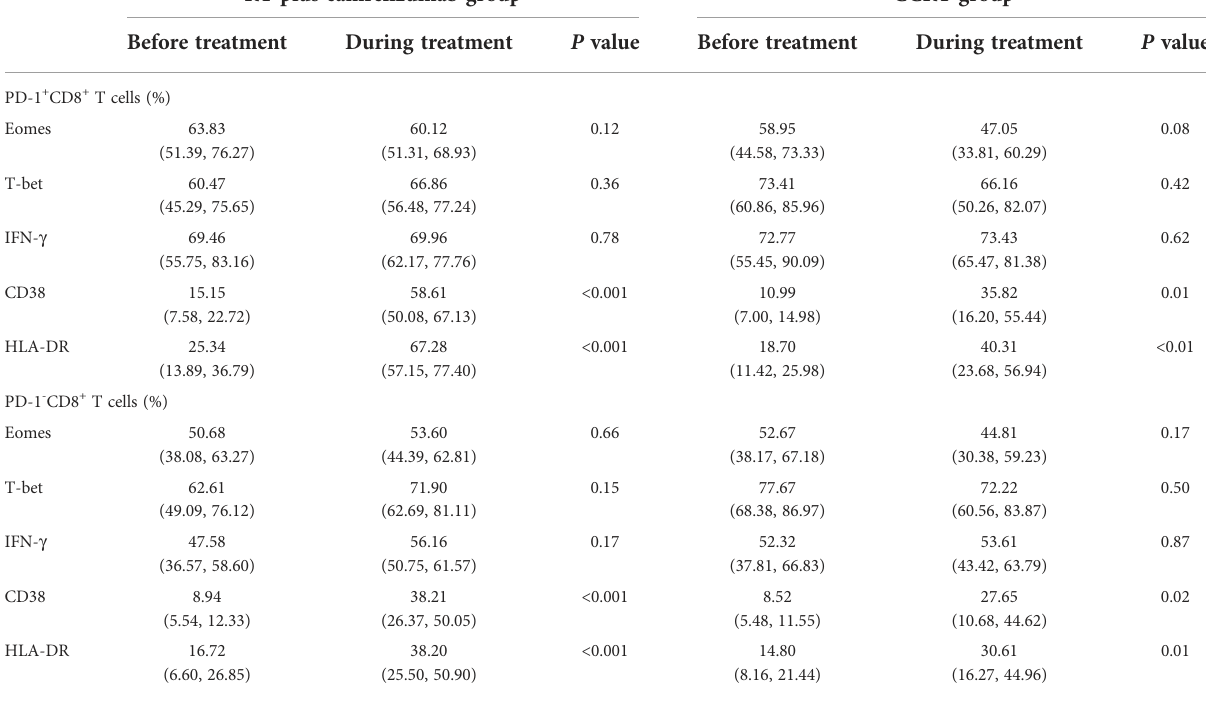
TABLE 2 The expression levels of molecule markers in PD-1 + and PD-1 - CD8 + T cells. RT plus camrelizumab group CCRT group Before treatment During treatment P value Before treatment During